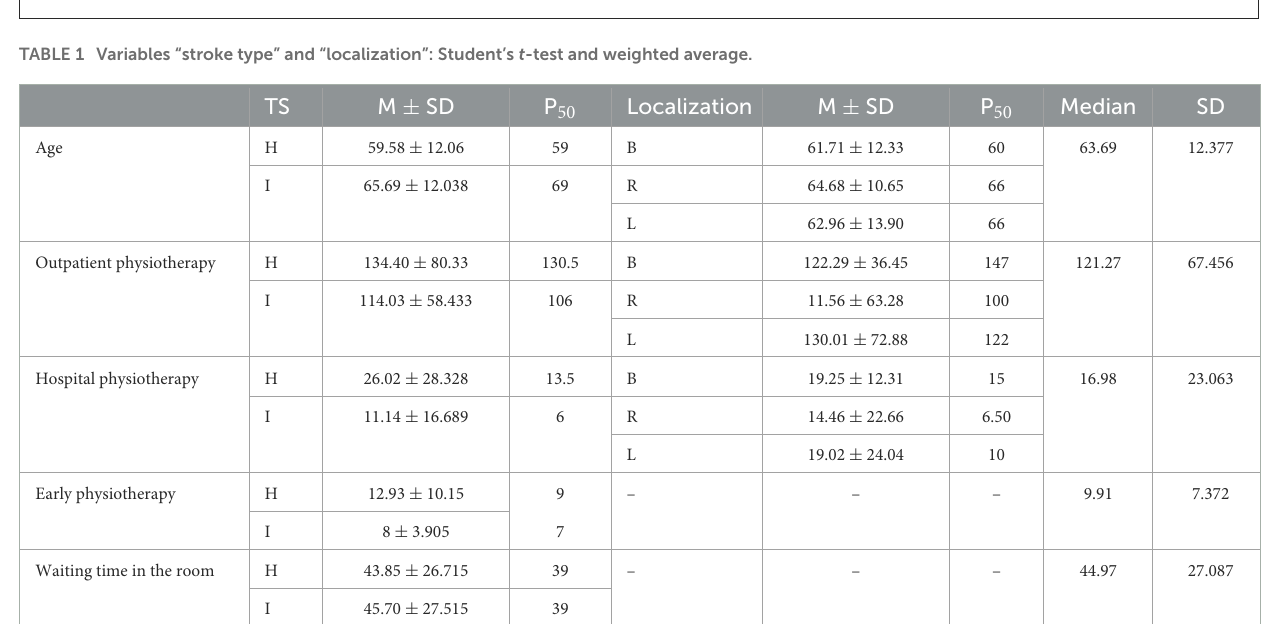
FIGURE2 Proportional distribution of study outcomes.